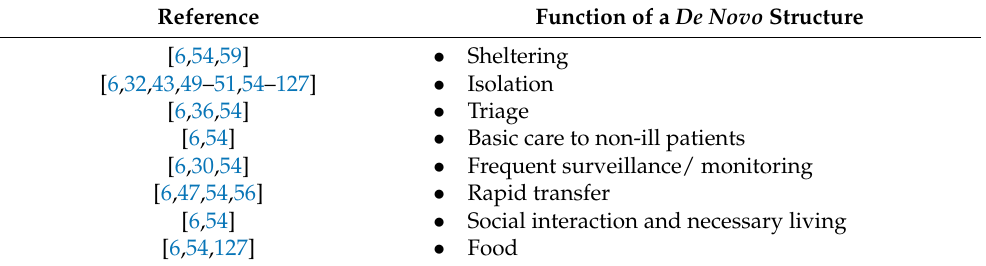
Table 3. Essential functions of de novo structures.